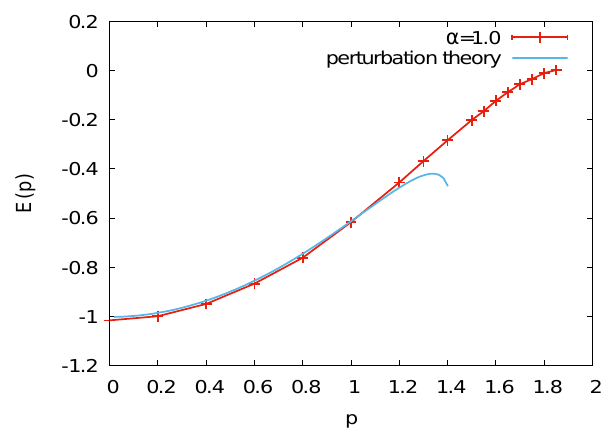
Figure 10: Dispersion E ( p ) of the Fröhlich polaron for α = 1 compared to the perturbative (cid:112) (cid:112) 2 result p 2 / ( 2 m ) − α arcsin ( p / 2 ) − 0.0026 [ 25 ] . Error bars are shown but may be too small p